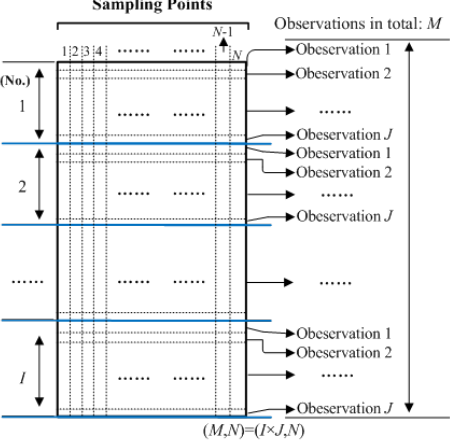
Figure 3. Structure of the original